Question: Give a one-sentence summary of this figure.
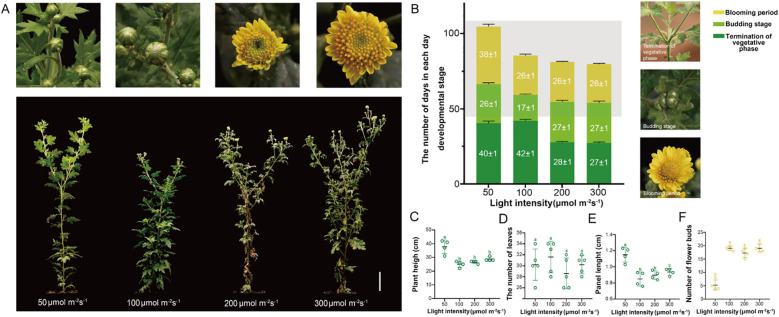
Answer: Phenotypic characteristics of ‘Xiaokuixiang’ under different light intensities. (A) Flowering phenotype; Scale bar = 5 cm. (B) Growth period, the shaded area indicating the start of short-day conditions. (C) Plant height. (D) Leaf number. (E) Internode length. (F) Number of flower buds.